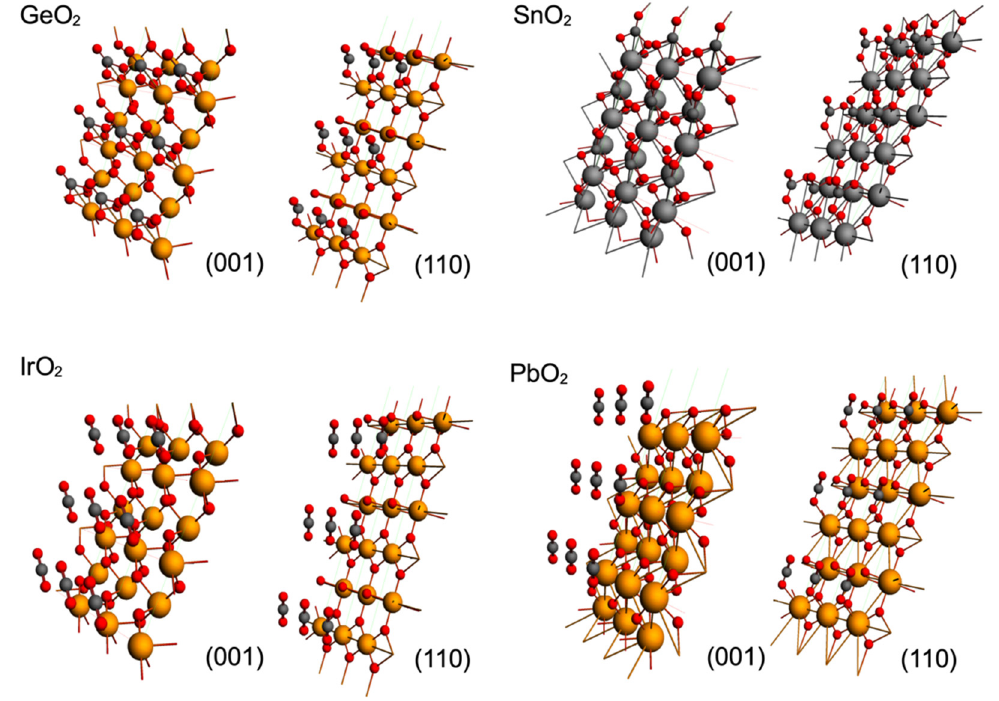
Figure 4. Optimized geometries for GeO 2 , SnO 2 , IrO 2 and PbO 2 rutile-type surfaces on (001) and (001) planes. Metallic cations are shown as large orange spheres, oxygen atoms as red spheres and carbons as dark grey spheres.